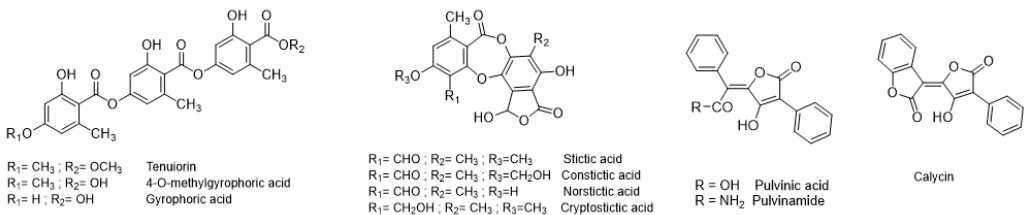
Figure 2. P. crocata thallus cross section that shows four distinctive layers and the basal part fixed to the substrate, called tomentum. Scale bar corresponds to 500 µ m.